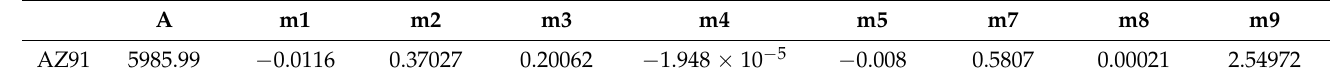
Figure 2. Work-hardening curves for the strain rate range of (0.1 s − 1 –10.0 s − 1 ) at a temperature of: ( a ) 200, ( b ) 300, and ( c ) 400 °C. (Black indicates the experimental curves; red indicates the approximated curves) [15]. Table 2. Parameter values obtained from the approximation of Equation (1).